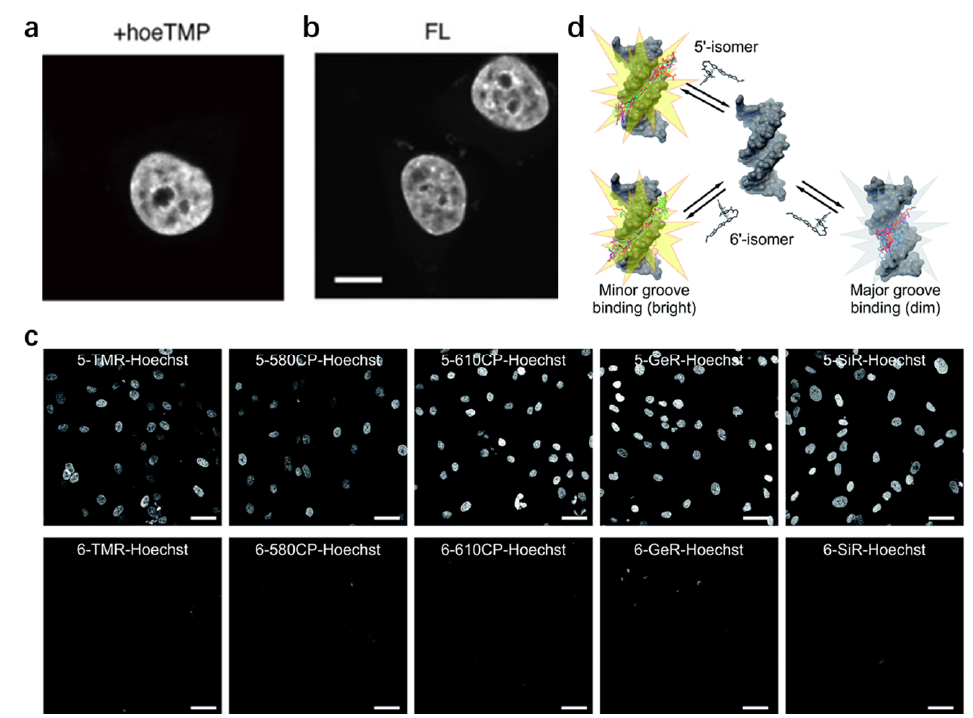
Figure 5. Structures of probe 1, probe 2, probe 3, SiR-Hoechst and HoeSR.